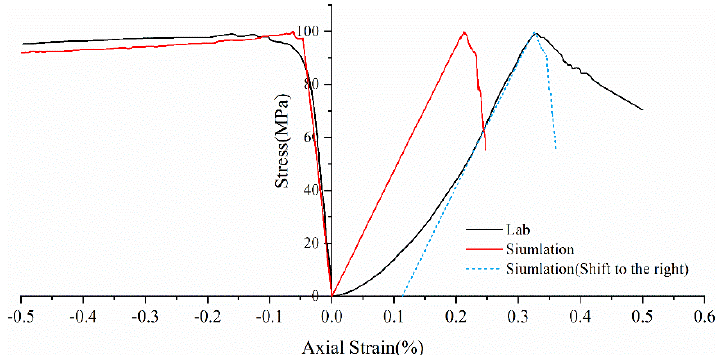
Figure 6. Comparison of stress–strain curves between numerical simulation and experiment (the blue dotted line is the comparison curve).